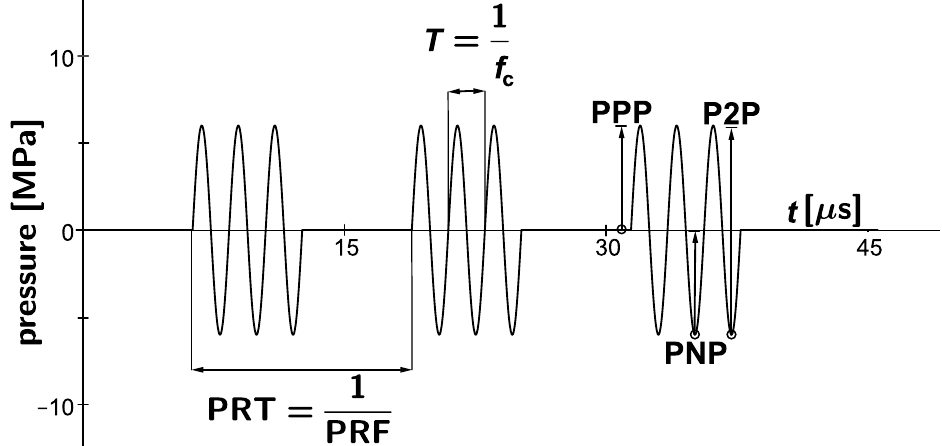
Figure 2. Representation of an ultrasound pulse sequence with dominant period T , centre frequency f c , peak-positive pressure (PPP), peak-negative pressure (PNP), peak-to-peak pressure (P2P), pulse-repetition period (PRT), and pulse-repetition frequency